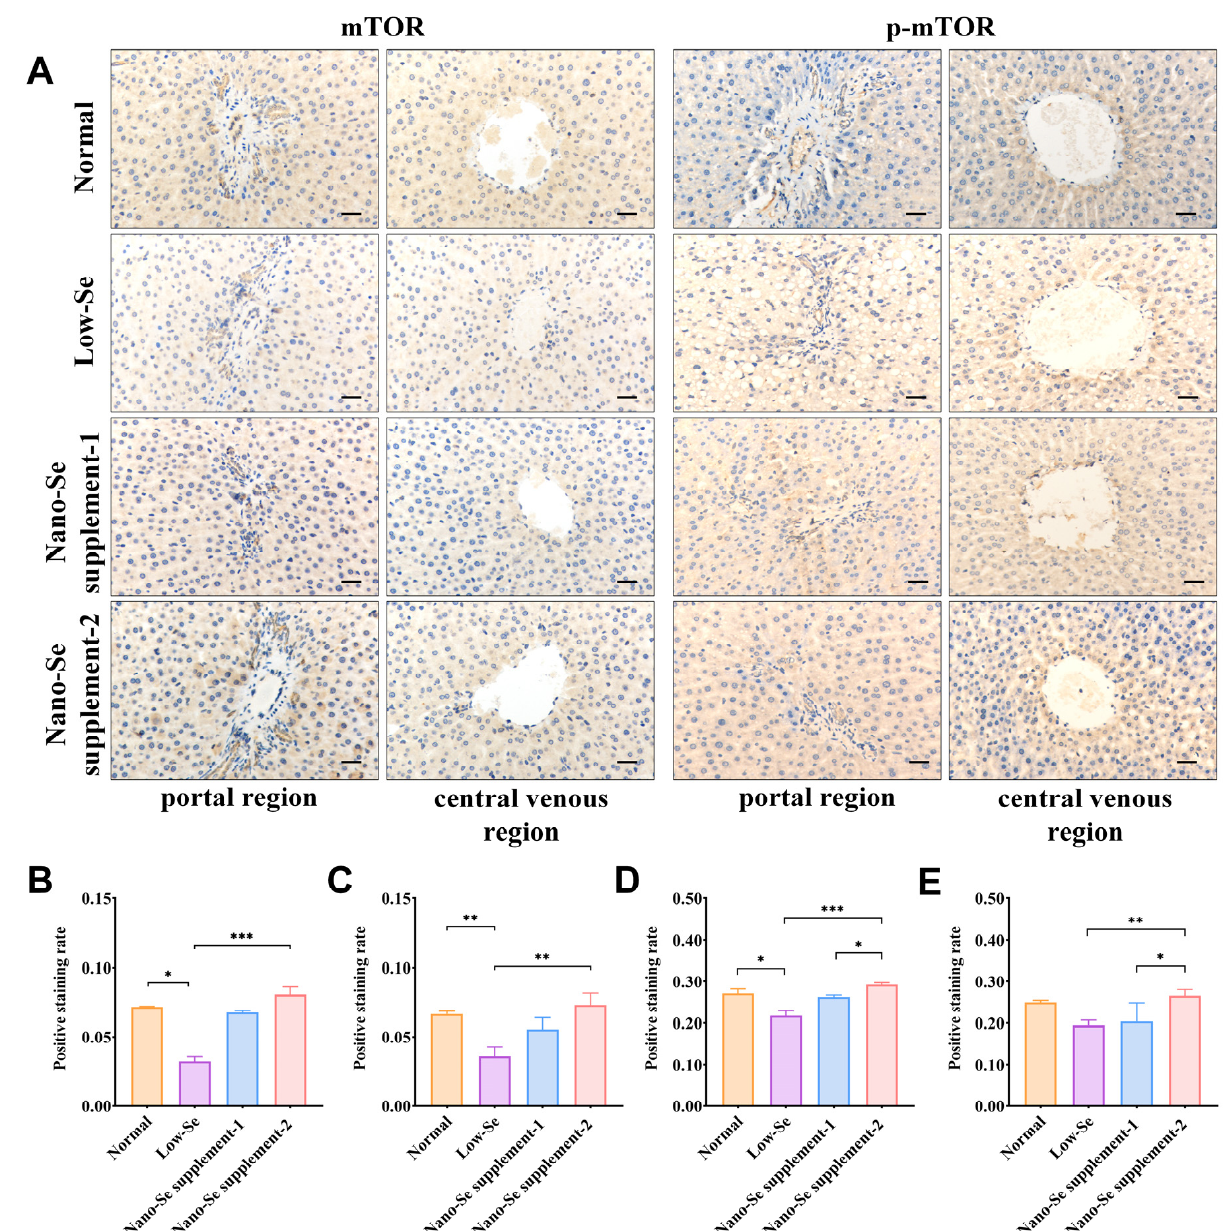
Figure 4. IHC staining results of mTOR and p-mTOR of livers in different groups. ( A ) Representative IHC staining of mTOR and p-mTOR in the portal and central venous regions. ( B , C ) The positive staining rates of mTOR in the portal and central venous regions. ( D , E ) The positive staining rates of p-mTOR in the portal and central venous regions. Scale bar: 200 µ m. * p < 0.05, ** p < 0.01, *** p < 0.001. Se: selenium; mTOR: mammalian target of the rapamycin; p-mTOR: phosphorylation-modified